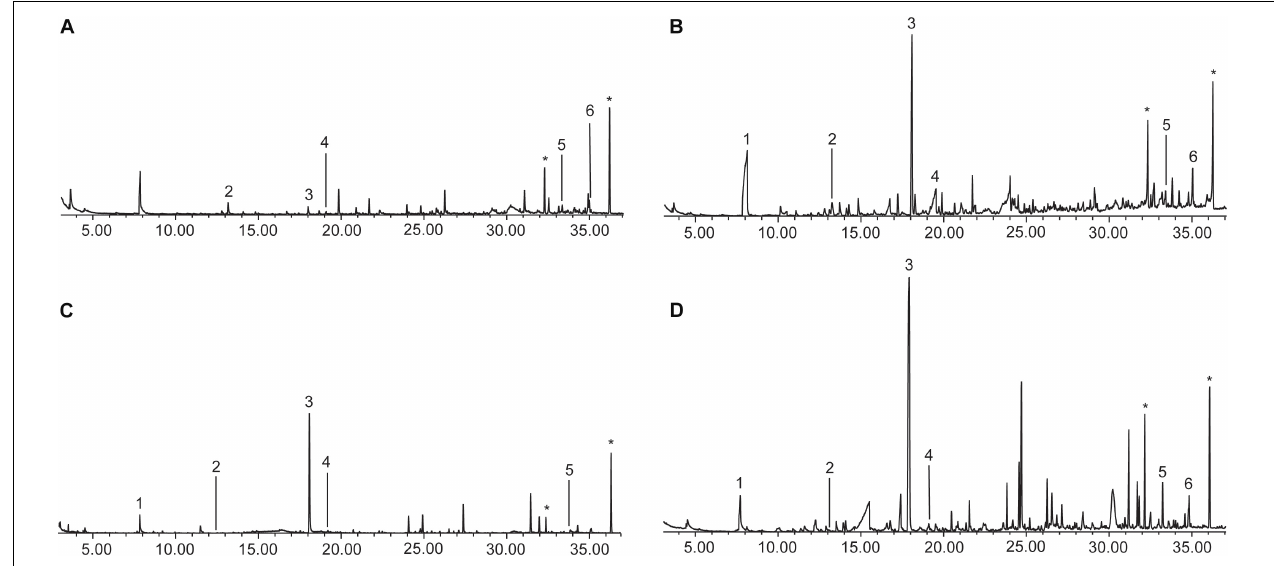
FIGURE 1 | Typical total ion chromatograms (TIC) of a urine extract of a male (A) and a female (B) M. murinus and a male (C) and a female (D) M. lehilahytsara . Overall, females produce more compounds in higher quantities compared to males. 1 = dimethyl sulfone, 2 = 4-methylphenol, 3 = quinoline, 4 = nonanoic acid, 5 = 1-hexadecanol, 6 = hexadecanoic acid,